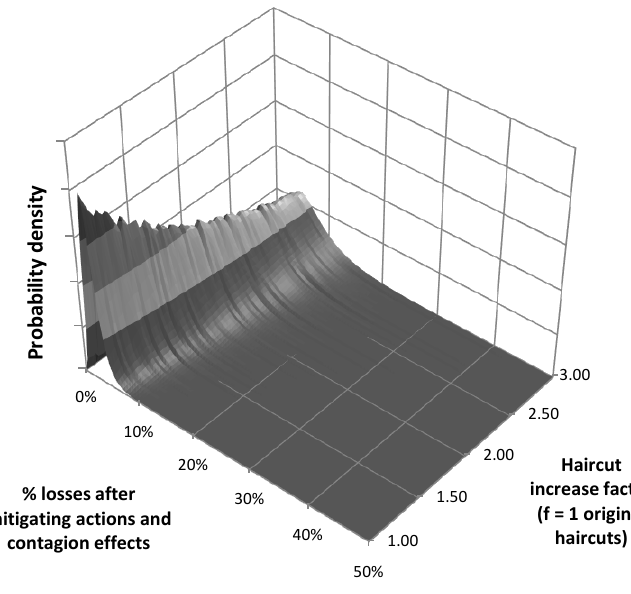
FIGURE 15: UK 2005, buffer restoration model illustrating haircut factors Possible losses of the liquidity buffer stemming from the increased haircuts for the UK banking system in the non-crisis period are shown in FIGURE